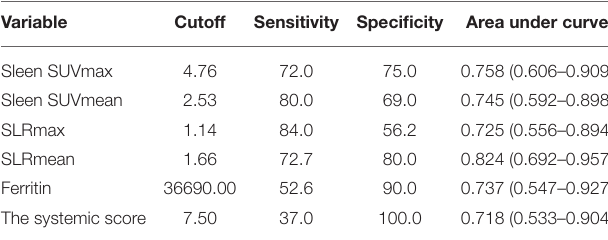
TABLE 4 | Comparison of metabolic parameters and ferritin and the systemic score in differentiating between AOSD recurrence group and non-recurrence group.